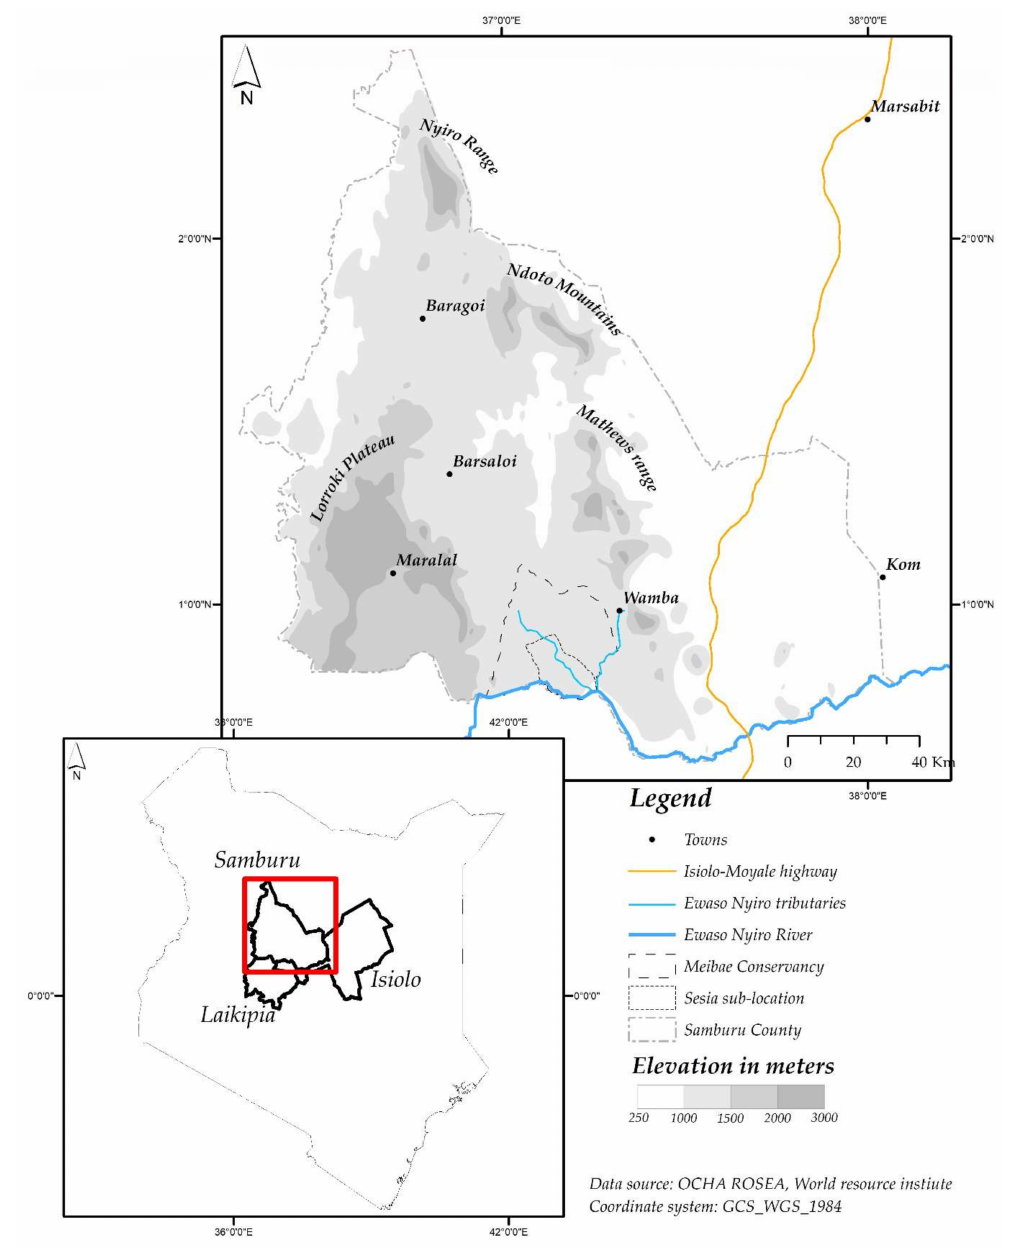
Figure 1. Sesia in Samburu,